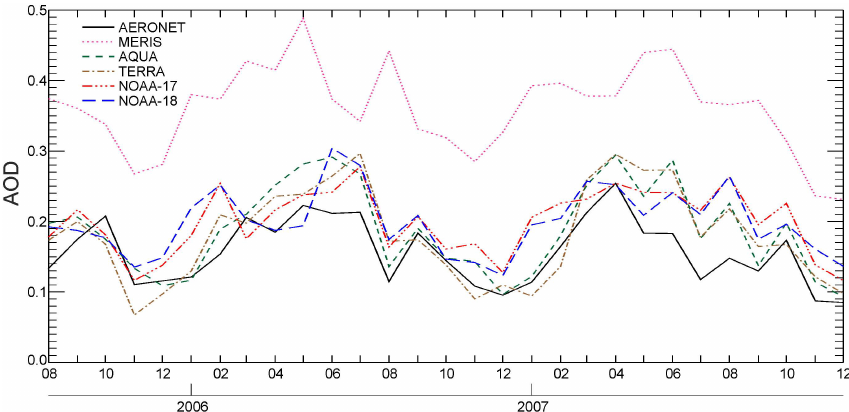
Fig. 8. Combined monthly values from the average of all sites together for each of the 29 months between August 2005 and December 2007 (cf. Sect. 4.3.2).